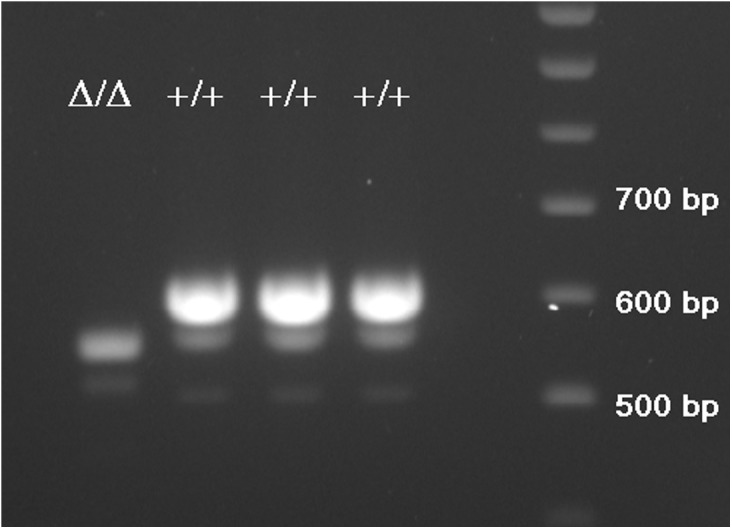
Agarose gel electrophoresis of equine CSN1S2 cDNA.The RNA was isolated from the milk of a mare being homozygous for the deletion (Δ/Δ).and three mares homozygous for the long variant (+/+).